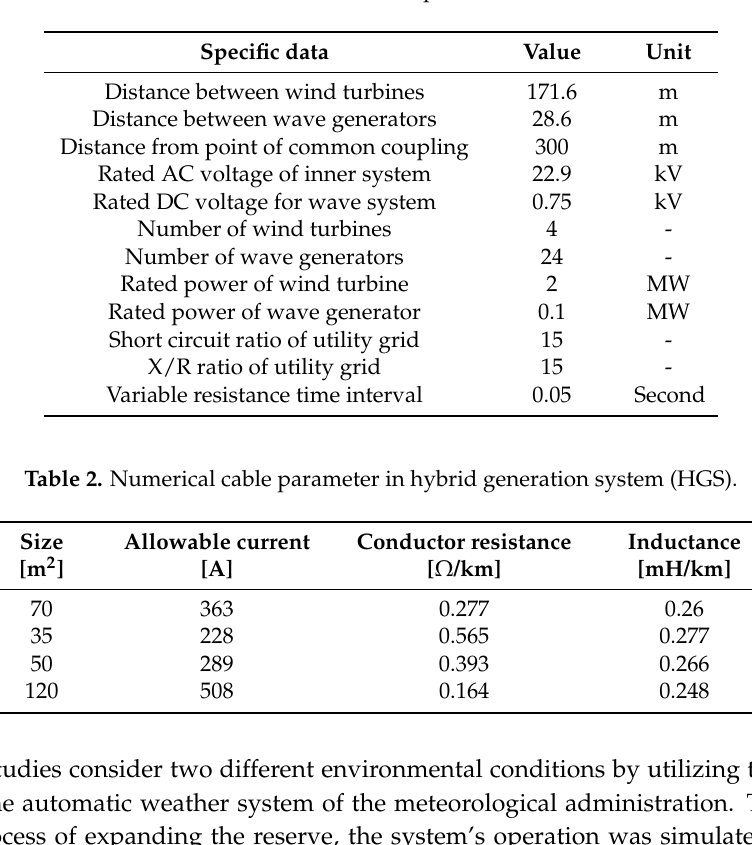
Table 1. Numerical data of the performed simulation.